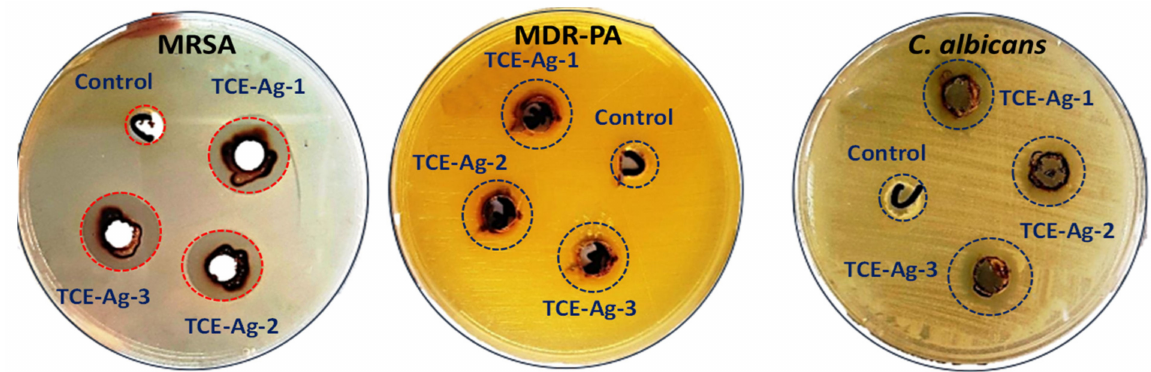
Figure 6. Comparative assessment of antimicrobial activity of TCE-Ag-1, TCE-Ag-2, and TCE-Ag-3 NPs against Gram- negative multidrug resistant P. aeruginosa (MDR-PA), Gram-positive methicillin resistant S. aureus (MRSA) and C. albi- cans cells. Table 2. Antimicrobial activity of TCE-Ag NPs against test strains of bacteria and fungi. Sr.